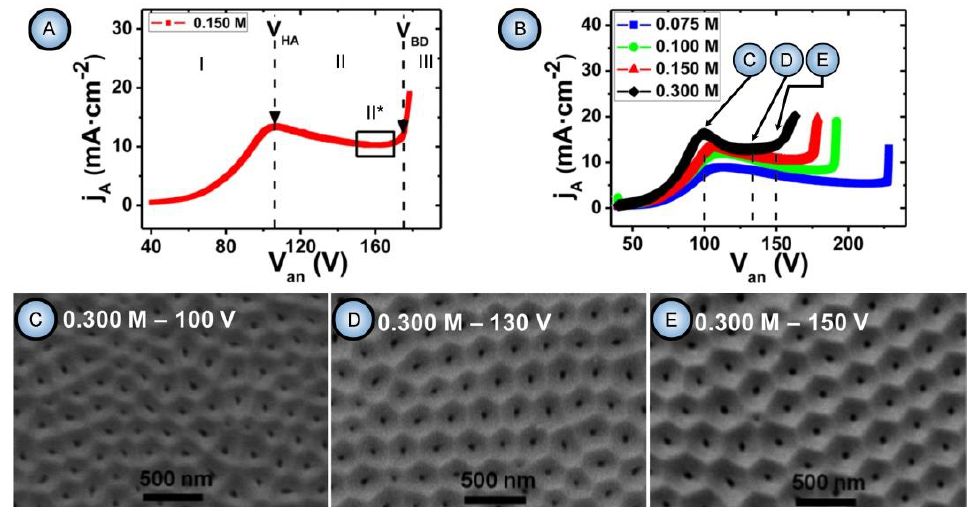
Figure 1. ( A ) A typical nonlinear j −∆ U curve for the formation of PAA divided into four stages labeled as I (“mild anodizing” regime, MA), II (“hard anodizing” regime, HA), II* (current plateau region which corresponds to the HA self-ordering voltages and is preceded by an intermediate “chaotic” state), III (dielectric breakdown), V HA (the beginning of II), and V BD (the beginning of III); ( B ) j –∆ U curves obtained for 0.075–0.3 M oxalic acid electrolyte solutions containing 5–10 vol % of ethanol; ( C – E ) SEM images demonstrating different degrees of pore ordering obtained at 100–150 V anodizing voltages using a 0.3 M oxalic acid electrolyte solution (corresponds to the black j –∆ U curve in ( B ), on which the tested voltages are shown by arrows and dashed lines). Adapted with permission from [5]. Copyright 2015 American Chemical